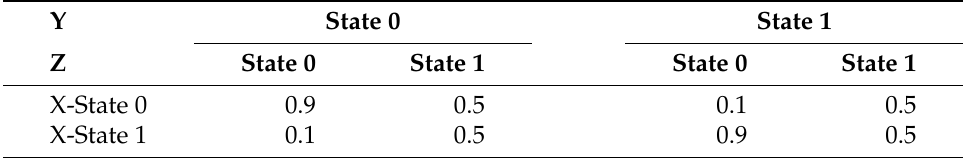
Figure 1. Example of a BBN, expressing the marginal probability of X. Table 1. Example of a conditional probability